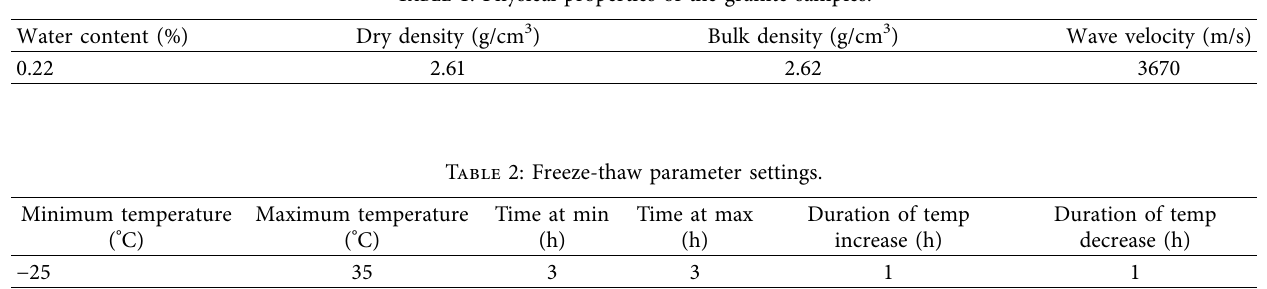
Table 1: Physical properties of the granite samples.